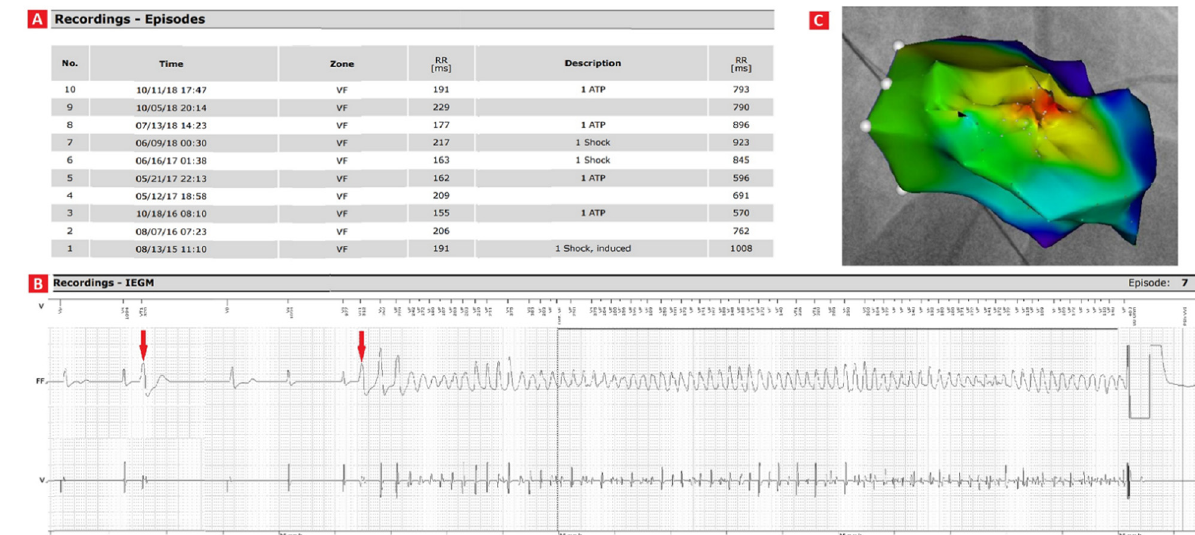
Figure 2. Ventricular fibrillation (VF) episodes resulting in implantable cardioverter-defibrilator (ICD) interventions, from the time of ICD reimplantation to the decision to perform radiofrequency ablation (A); ICD intracardiac recording showing the premature ventricular complex (PVC) triggering VF. VF initiating PVC is similar to the previously registered PVC (arrows) (B); Right anterior oblique 30° view of right ventricular endocardial activation map obtained during spontaneous PVCs: the earliest activation site was located in the antero-lateral right ventricular free wall (red area) (C). ATP – antitachycardia pacing, IEGM – intracardiac electrocardiogram, RR – consecutive R waves on the IEGM